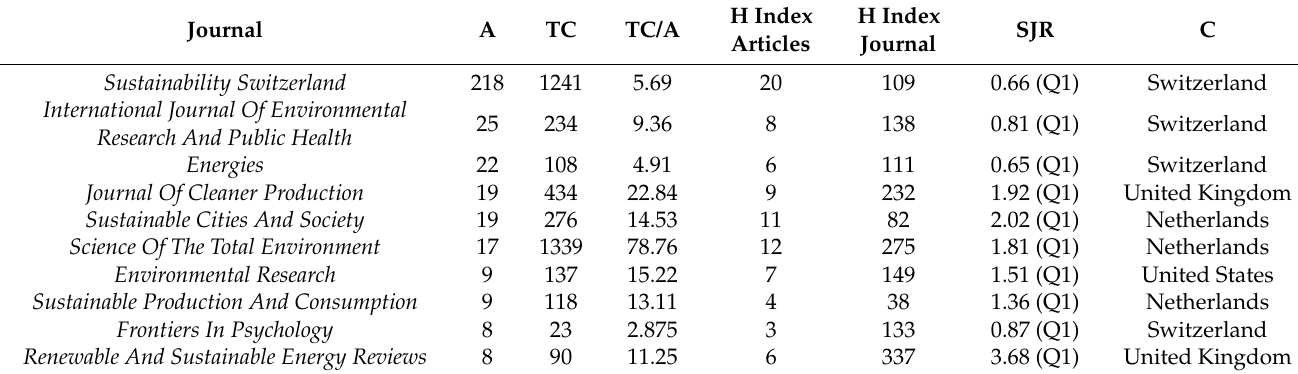
Table 7. The ten most productive journals.